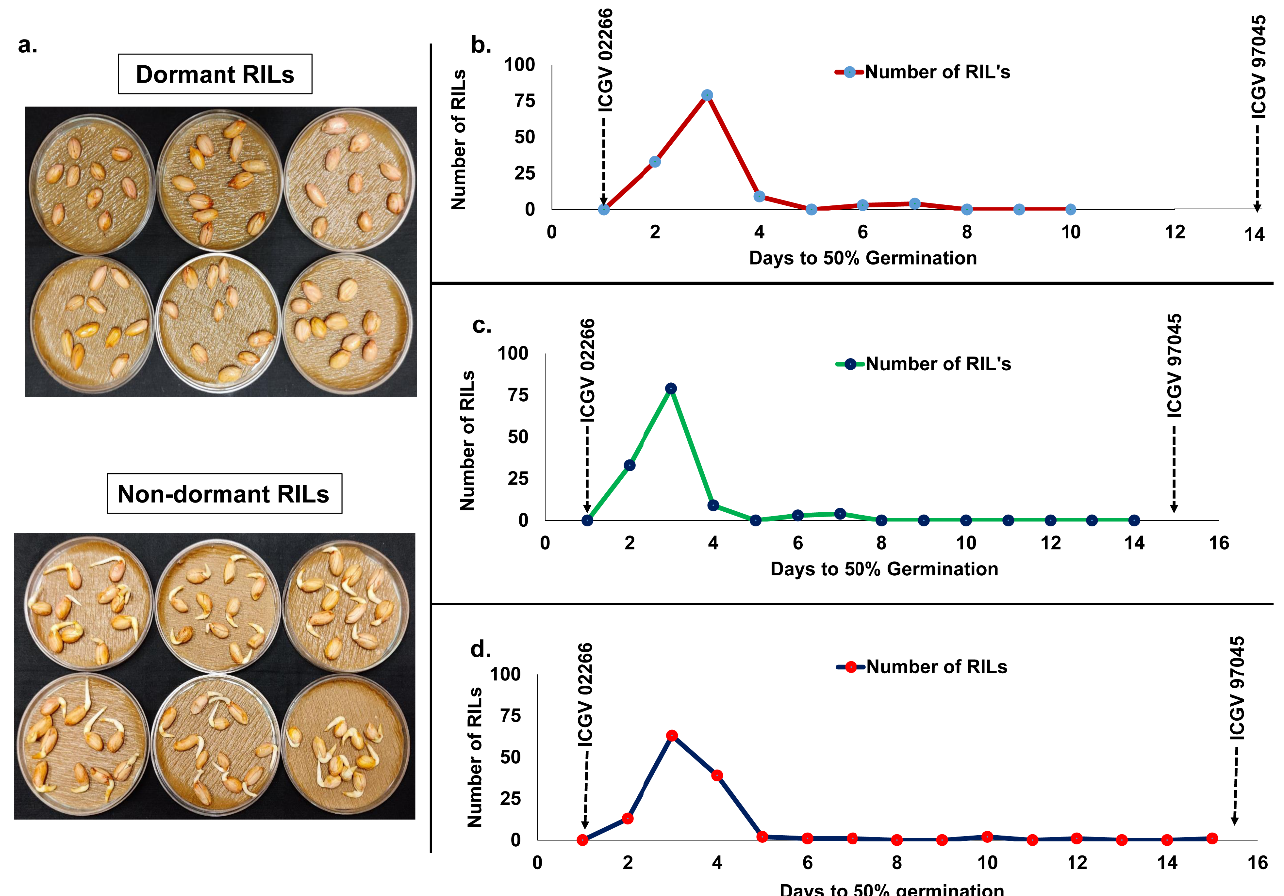
Figure 2. Fresh seed dormancy phenotypic variability in the RIL population (ICGV 02266 × ICGV 97045). Pictures of ( a ) dormant RILs 15 days after the FSD in vitro germination assay and ( b ) Non- dormant RILs 24 h after the FSD in vitro germination assay. The line graph represents phenotyping data of the RIL population along with dormant and non-dormant parents during ( b ) Post-rainy